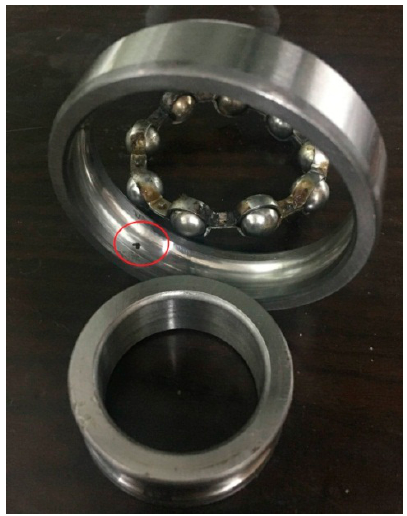
Figure 13. The picture of faulty bearing located in outer ring.